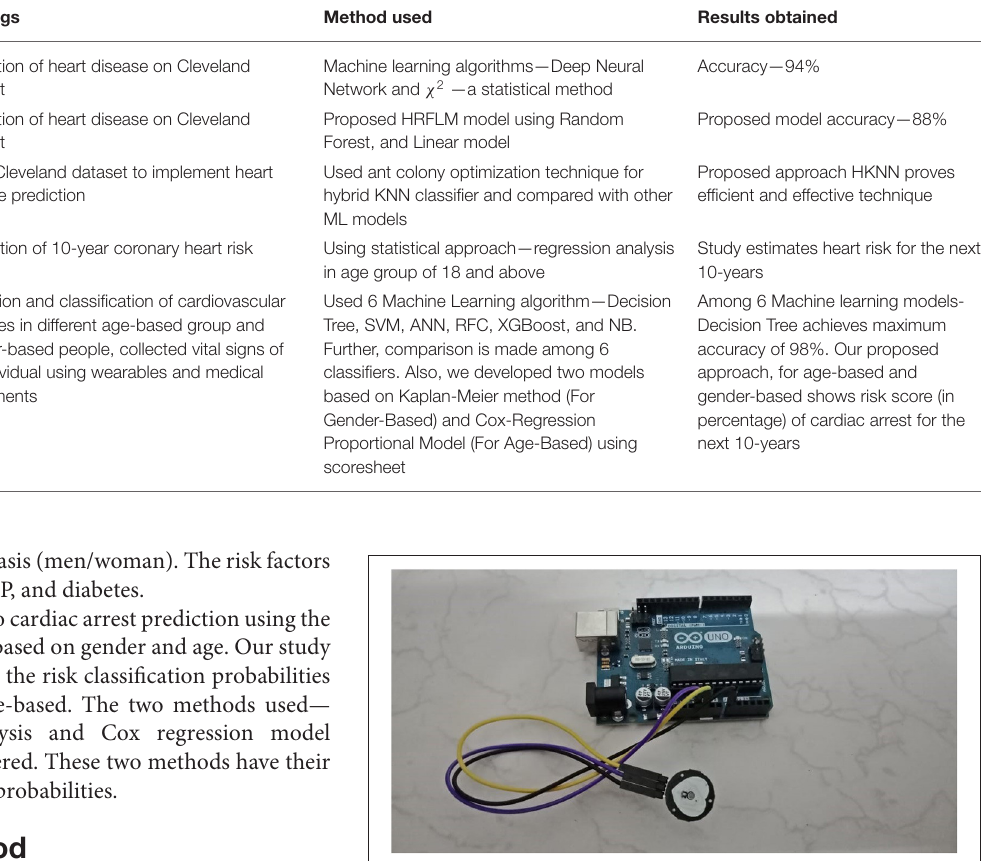
FIGURE 1 | Pulse sensor connected with Arduino.